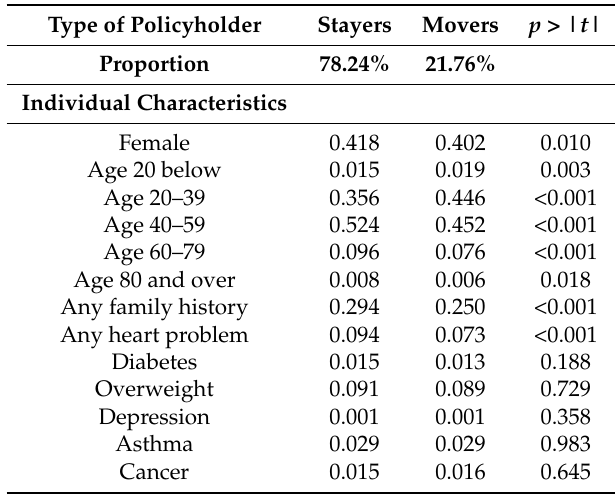
Table 4. Comparison between policyholders who stayed and moved